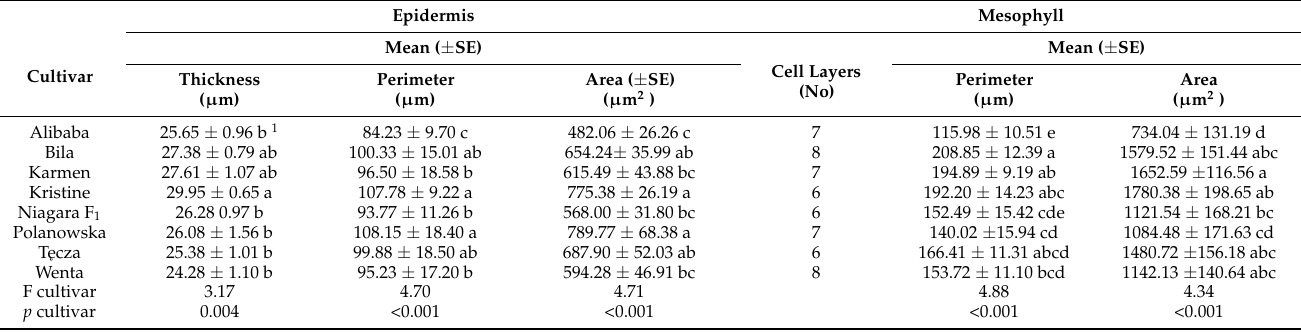
Table 8. The evaluated parameters of the leaf’s epidermal and mesophyll cells in evaluated eight different Allium cepa cultivars in 2016, df =